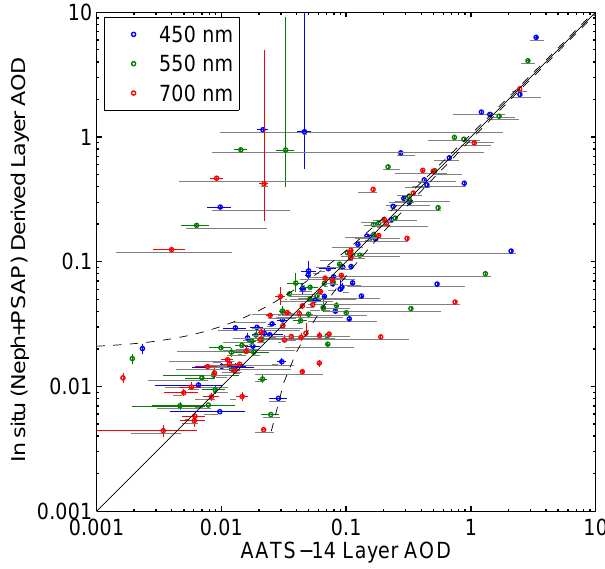
Fig. 5. Comparison of layer AODs derived by two methods. Plotted on the horizontal axis is the difference in AATS-14 AOD measured at two altitudes and interpolated to the nephelometer wavelengths of 450 (blue marker), 550 (green) and 700 (red)nm. On the ver- tical axis, the vertical integral of in situ scattering and absorption coefficients measured with nephelometer and PSAP is plotted. The solid and dashed black curves indicate the 1:1 correspondence and ± (3%+0.02) deviation, respectively. The colored horizontal and vertical lines associated with data points indicate estimated mea- surement uncertainties. The effect of spatial variability is indicated separately with grey horizontal lines. This represents the center 68% values of AOD at the bottom layer minus the snapshot top value, and does not necessarily include the snapshot layer AOD value